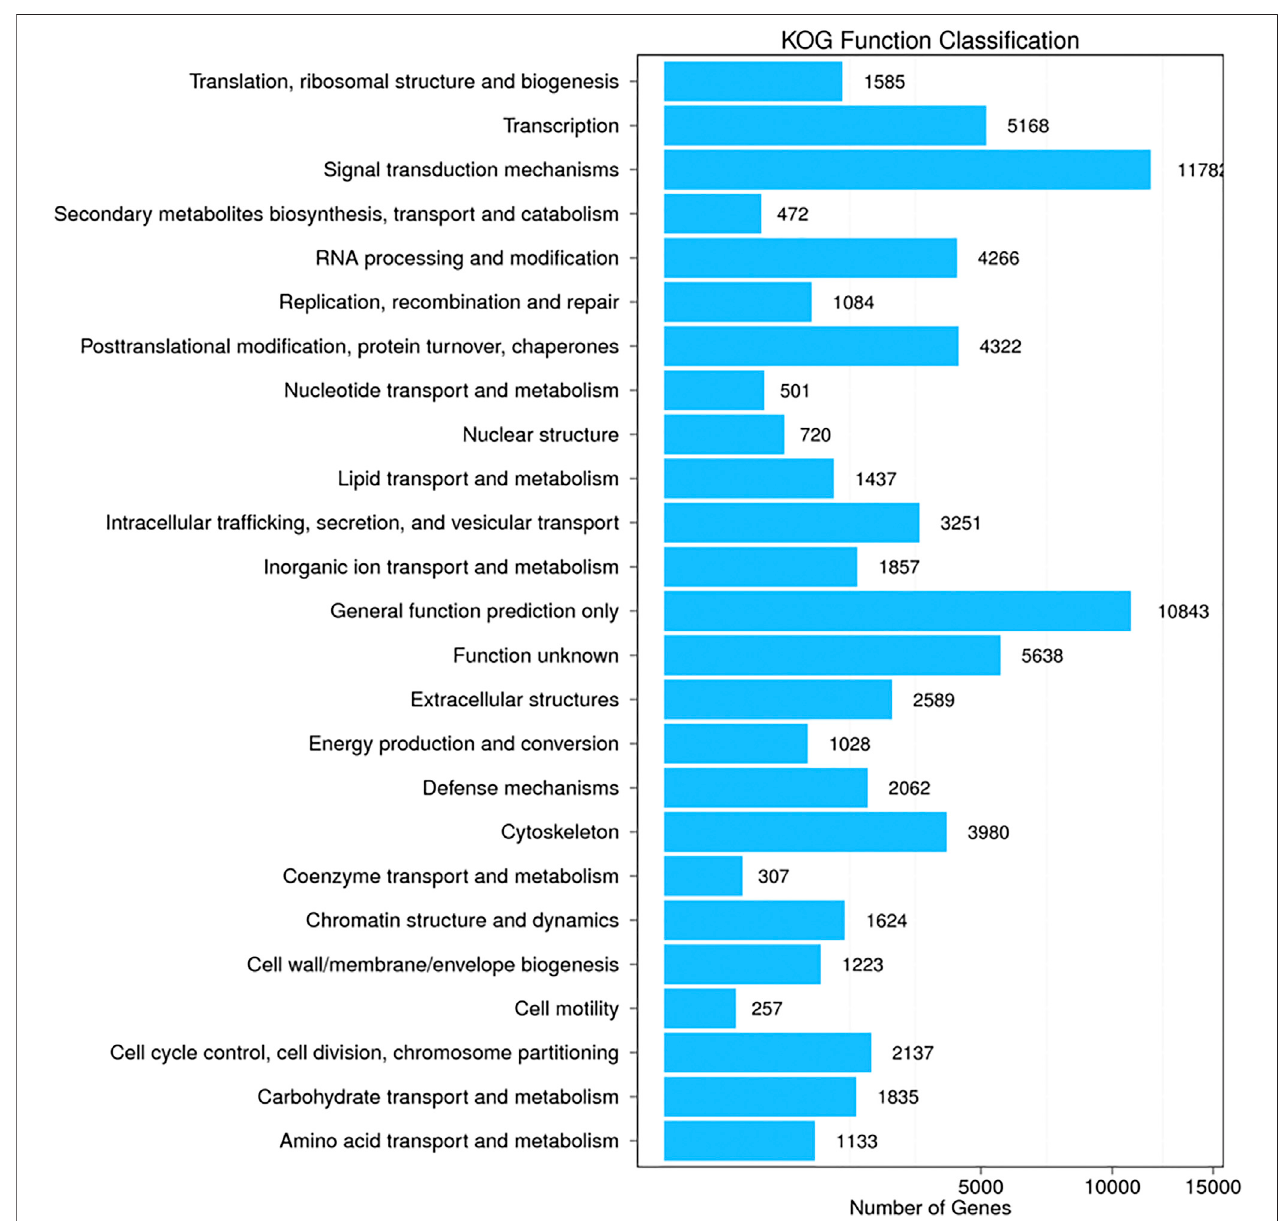
FIGURE 3 | Cluster of orthologous groups (COG) classi fi cation of all unigenes identi fi ed by the transcriptome analysis. The matched unigenes were classi fi ed functionally into 25 functional categories in the COG database. The number of unigenes in each functional category ranged from 257 to 11782.